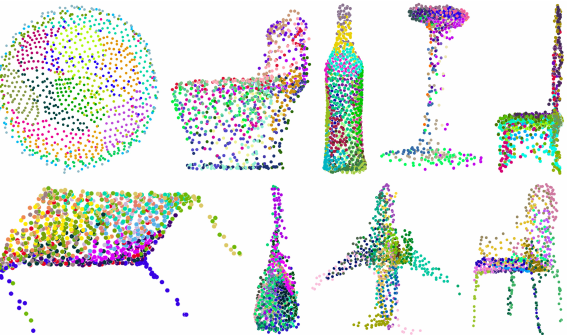
Figure 6. Visualization of point-cloud output by the multigrid